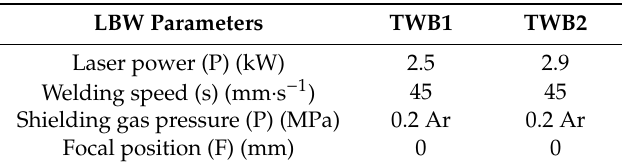
Table 3. Welding